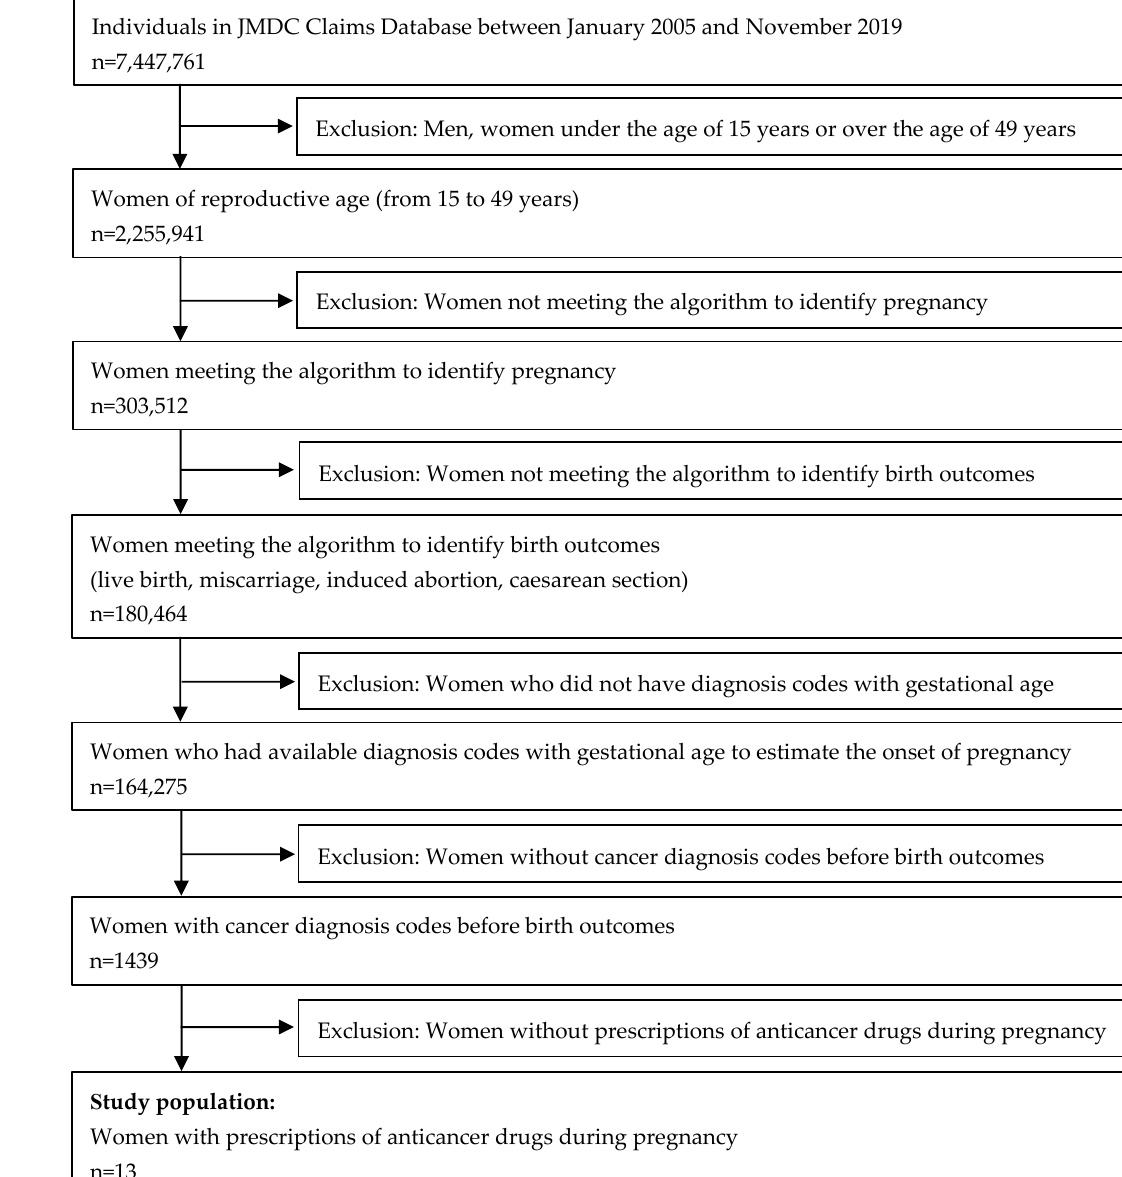
Figure 1. Selection of study